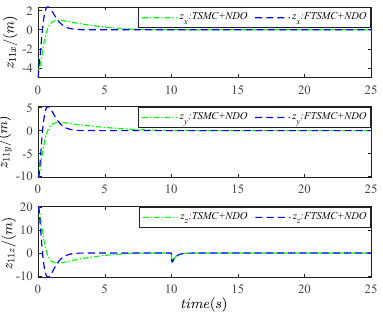
Figure 9. Position tracking error comparison curves of UAV1.